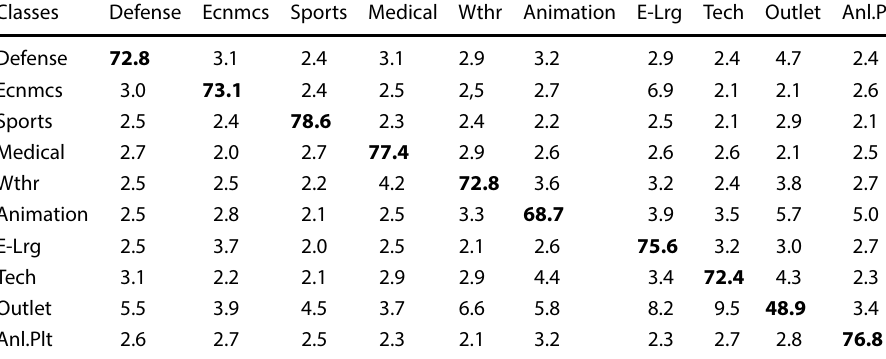
Table 6 Confusion matrix of Noisy Student [38] on STD dataset (ACR: 72.6)